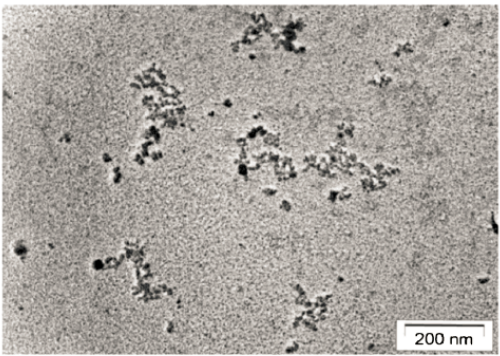
Figure 2. Electron microscopy image of cfCh isolated from pooled sera of cancer patients showing beads-on-a-string appearance typical of chromatin of disparate sizes. Reproduced from [64].